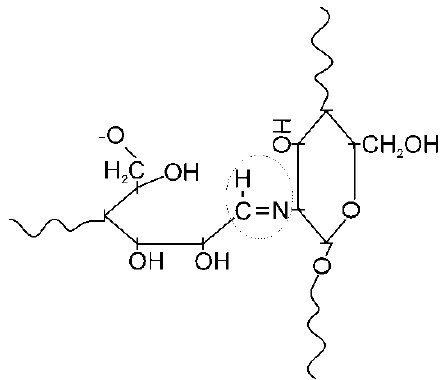
Figure 5. The formation of aldimine bonds during the interaction of the aldehyde end groups of HEC and amino groups of chitosan.